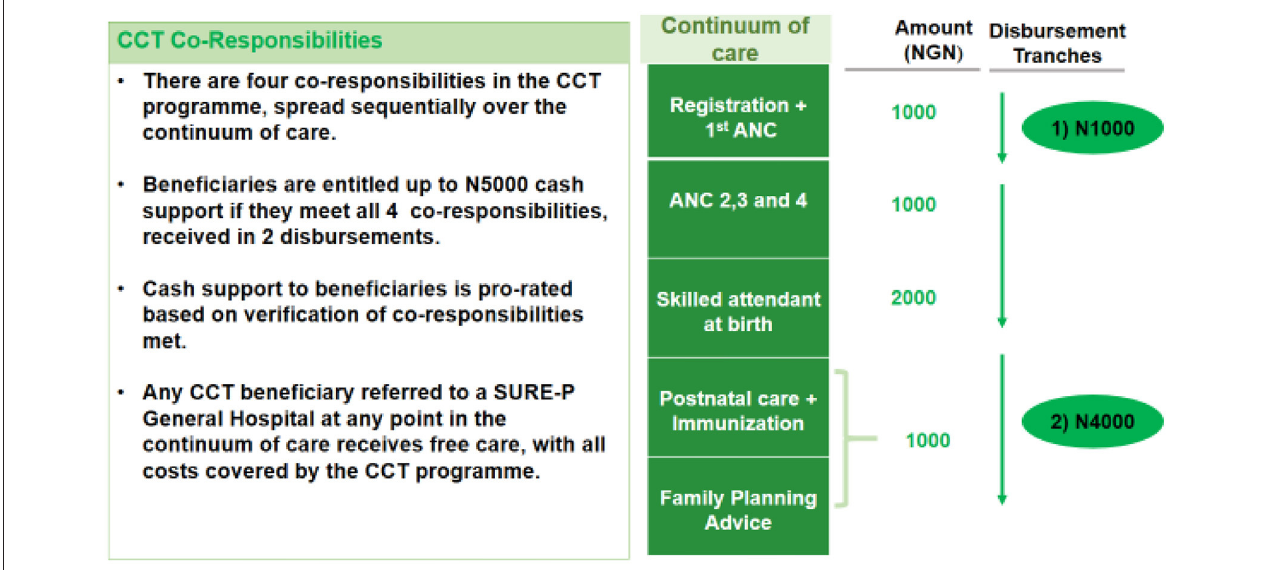
FIGURE 1 | Method of CCT payment. Source: MCH Programme Implementation Unit (PIU). The SURE-P MCH Conditional Cash Transfer Programme is designed to encourage women to register and complete the continuum of care for MCH services. By the end of 2013, ∼ 14,500 women had enrolled for the CCT Pilot Programme in eight states and the Federal Capital Territory